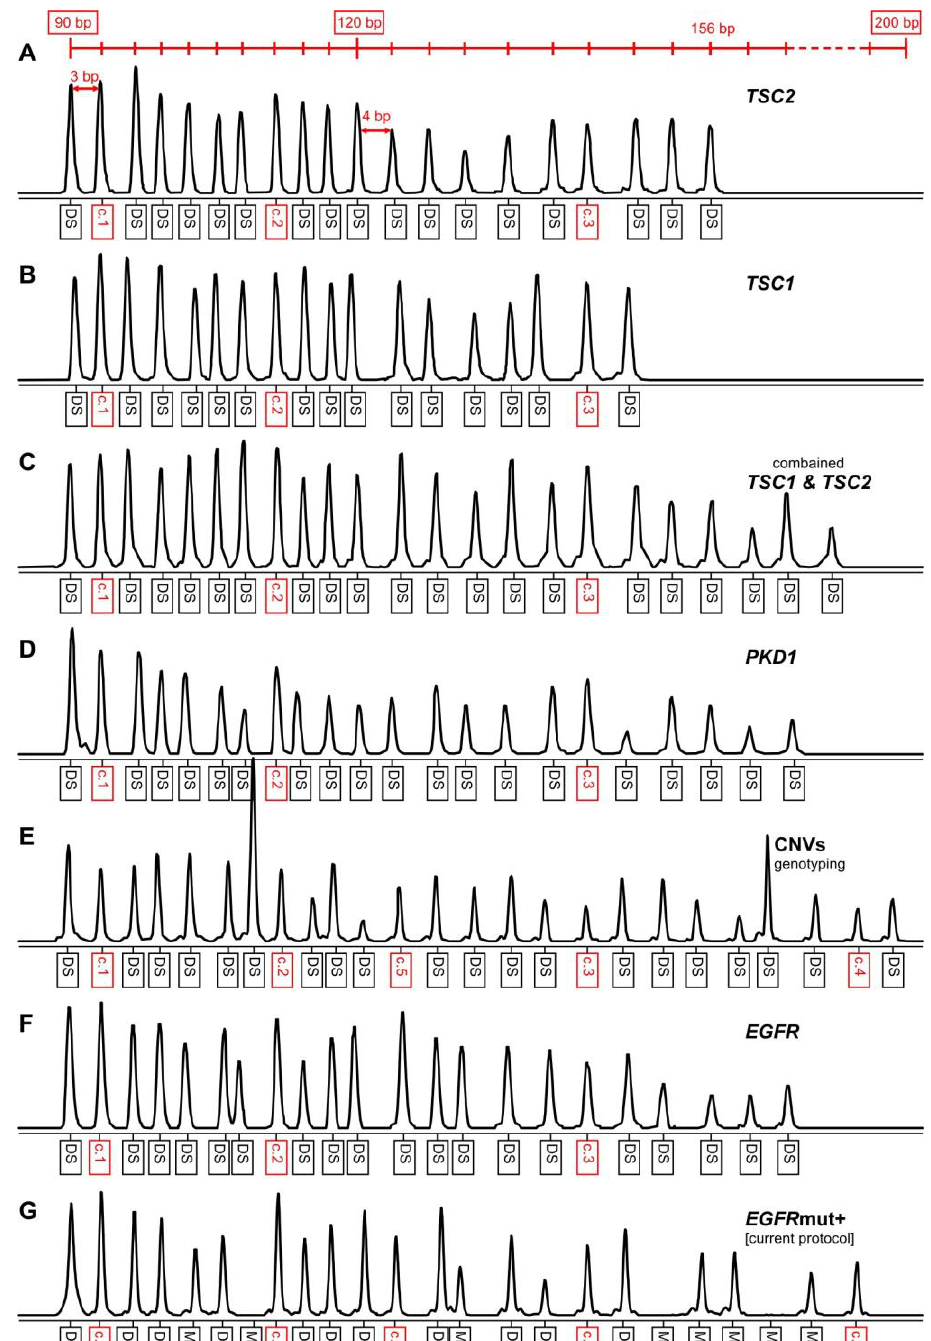
FIGURE 2. Examples of MLPA probe sets designed according to the described protocol. Electropherogram profiles representing a normal DNA sample analyzed with different MLPA probe sets (the signal of each probe [except panel E] represents two target sequence copies). (Top) Schematic representation of an MLPA probe set layout. Probe sets for large-mutation analysis in (A) TSC2 , (B) TSC1 , (C) both TSC1 and TSC2 , and (D) PKD1 . (E) Probe set for genotyping several polymorphic CNVs at different sites in the genome. (F) Probe set for CNV analysis of EGFR . (G) Probe set for combined copy number and small-mutation analysis of EGFR (the assay described in this article). The types of the MLPA probes are indicated under the electropherograms. Control probes are indicated in